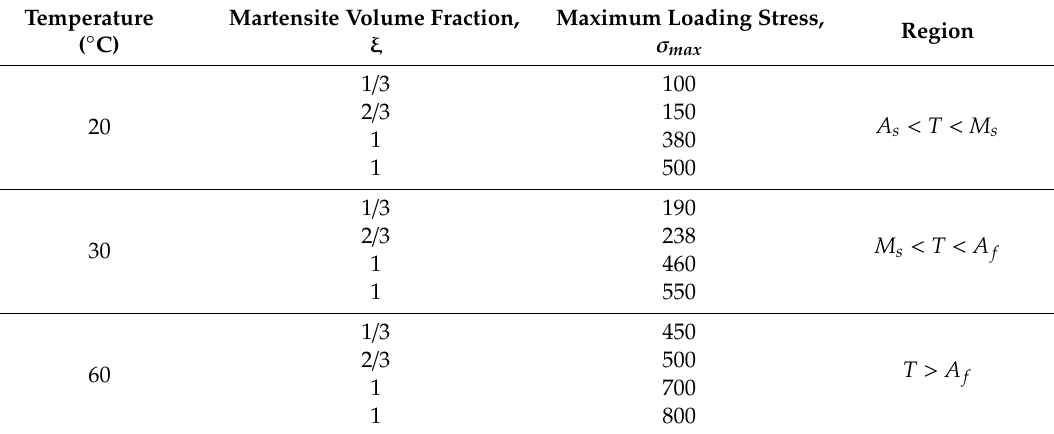
Table 2. Simulated Operating Temperature and Loading